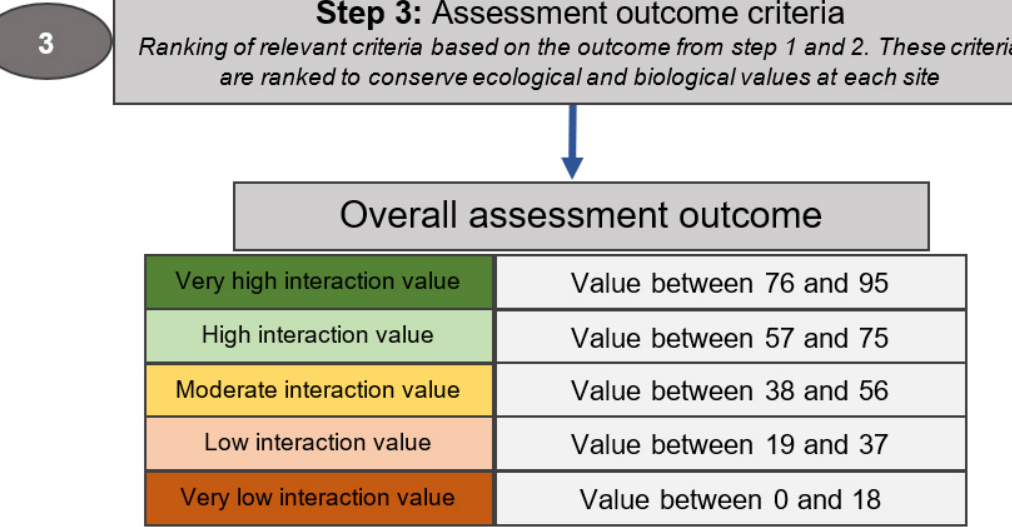
Figure 1. Consolidation approach encompassing the three steps used to determine an overall assessment outcome at each of the geoconservation